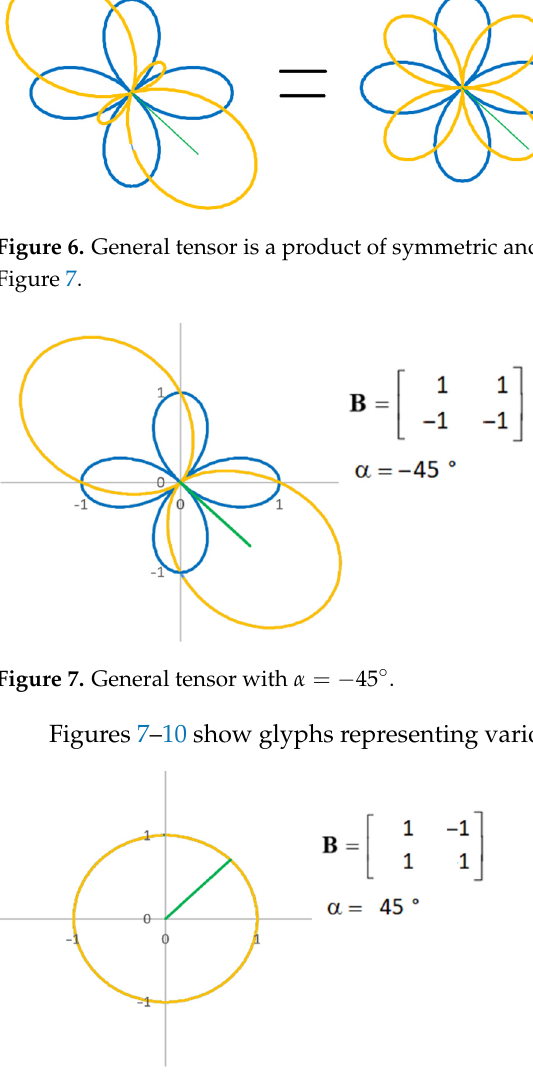
Figure 8. General tensor with 𝛼 = 45° .